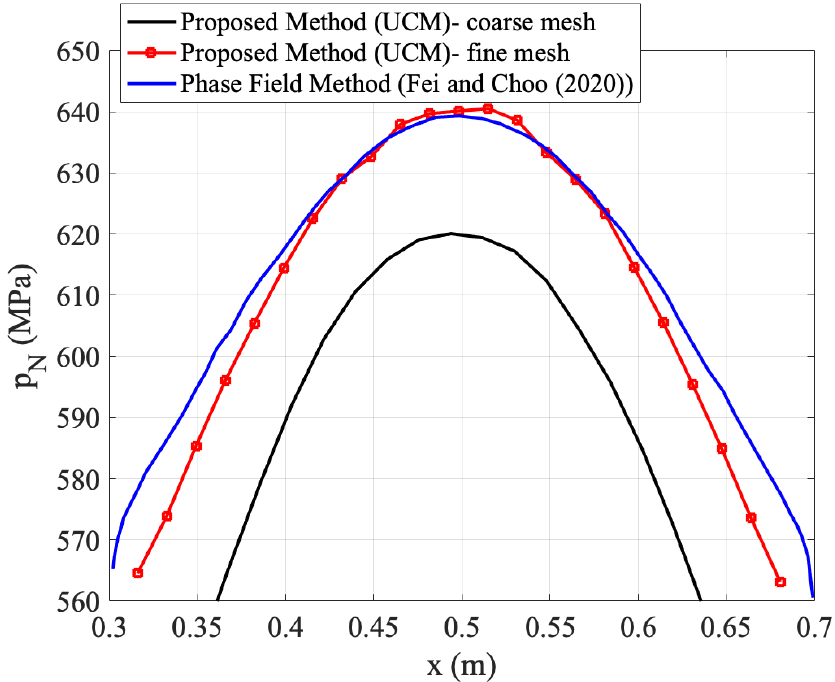
Figure 8. Normal contact stress along the crack at the final step for the uncoupled model (UCM) in comparison with Fei and Choo